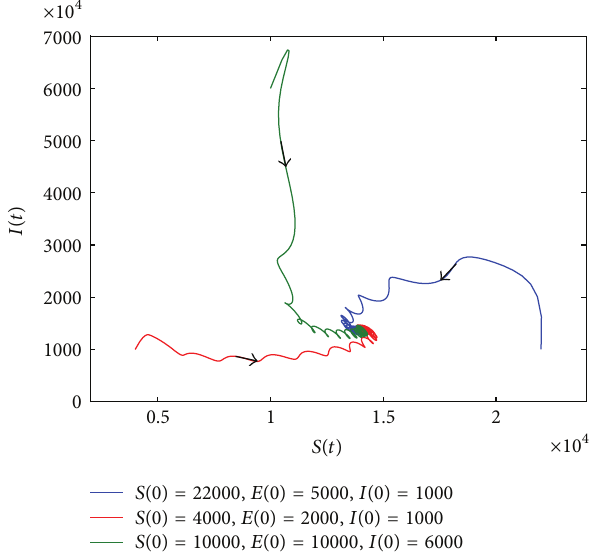
Figure 5: Phase plane of 𝑆(𝑡) and 𝐼(𝑡) . When the parameter values are 𝑟 = 0.13 , 𝑎 = 0.36 , and 𝑏 = 0.2 , 𝑅 0 = 1.0834 , 𝑅 𝑑 = 1.3 > 1 , 𝑅 𝑑 > = 1.0435 , and 𝑅 > 𝑅 𝑙 = 1.029 . The value of other parameters 𝑅 𝑢 𝑑 1 1 can be seen in Table